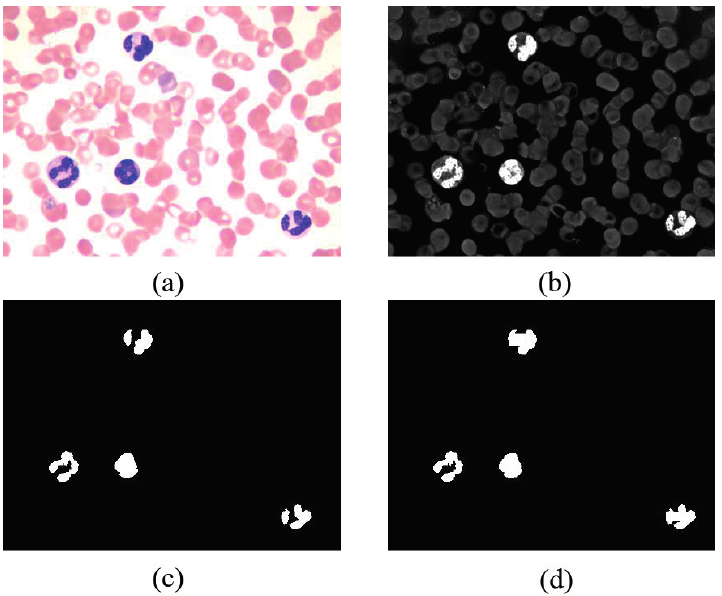
Figure 4. ( a ) Original RGB image in peripheral blood smear; ( b ) Enhanced nucleus images; ( c ) Segmented nucleus binary image; ( d ) Inside seeds after the centroid-connected